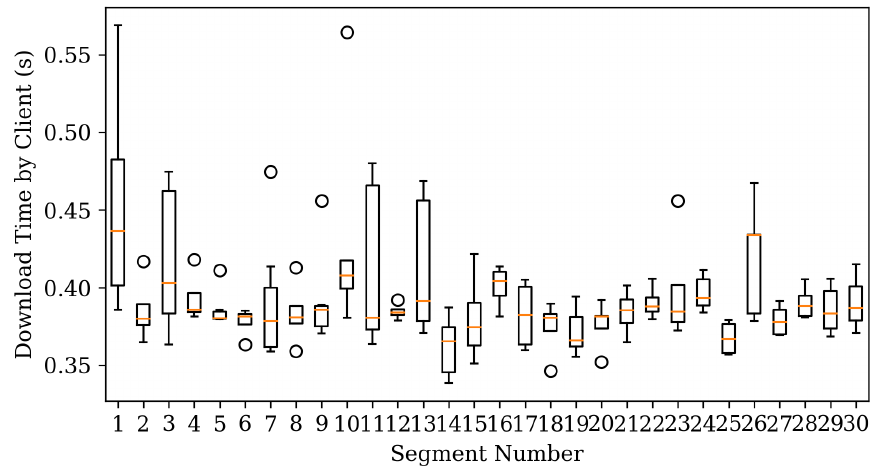
Figure 7. RL scheduler performance change over